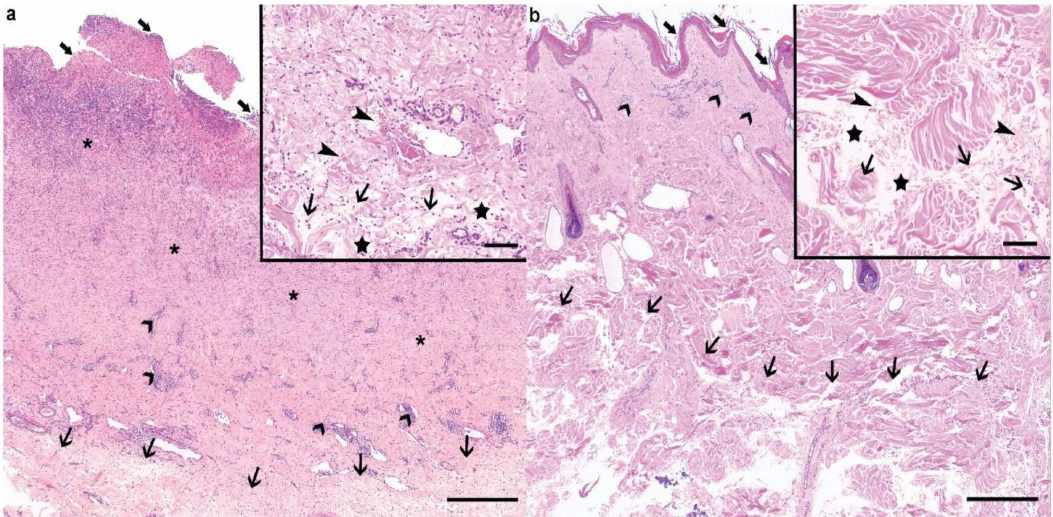
Figure 3. Histological findings of the cEDS-a ff ected Holstein calf and its dam. ( a ) The ulcerated (large arrows) cervical lesion from the calf displayed a prominent granulation tissue proliferation (asterisks) associated with neovascularization and severe neutrophilic infiltration. Moderate, lymphoplasmacytic perivascular infiltrates were visible in the superficial dermis (large arrowheads). Within the deeper dermis, the collagen bundles were loose and irregular (thin arrows). Haematoxylin and eosin (H&E), bar 500 µ m. Inset: higher magnification of the a ff ected connective tissue within the deeper dermis. The collagen bundles were wavy, short, and thin (thin arrows), and surrounded by edema (stars) and acute hemorrhage (thin arrowheads) in the absence of vascular changes. Haematoxylin and eosin (H&E), bar 100 µ m. ( b ) In the dam, the epidermis was irregular, mildy hyperplastic, and layered by large amount of lamellar to compact, orthokeratotic keratin (large arrows). Mild to moderate, perivascular lymphocytic and plasmacellular infiltrates were visible in the superficial dermis (large arrowheads), while similar changes to the ones described in the calf could be observed in the deeper dermis (thin arrows). Haematoxylin and eosin (H&E), bar 500 µ m. Inset: Higher magnification of